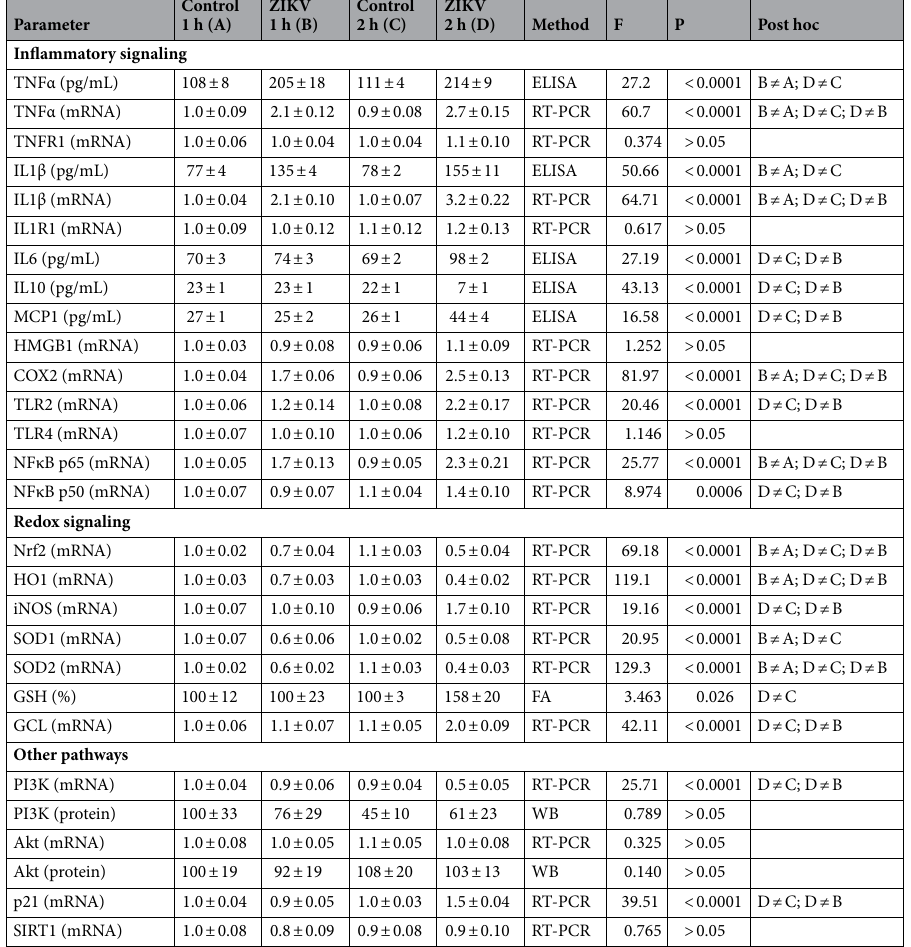
Table 1. Effects of ZIKV on inflammatory/redox signaling and associated pathways. Hippocampal slices from adult Wistar rats were incubated with medium containing ZIKV (10 2 to 10 6 PFU) for an adsorption period of 1 h. Afterwards, this medium was exchanged for fresh saline medium for 1 h or 2 h, and the parameters presented in Table were measured, as described in the “Methods”: section. Data are expressed as: (i) pg/ mL for ELISA assays; (ii) fold increase for mRNA levels (RT-PCR); (iii) percentages of control for protein levels (Western blotting—WB); (iv) GSH content (fluorimetric assay—FA). Differences among groups were statistically analyzed using one-way analysis of variance (ANOVA), followed by Tukey’s test (n = 6 per group, except for the WB analysis in which at least three experimental determinations were performed). Values of P < 0.05 were considered significant. P values are indicated in the Table. Treatment groups that differ significantly are listed in the Post hoc column. The representative images of WB are in the Supplementary Material (Fig.